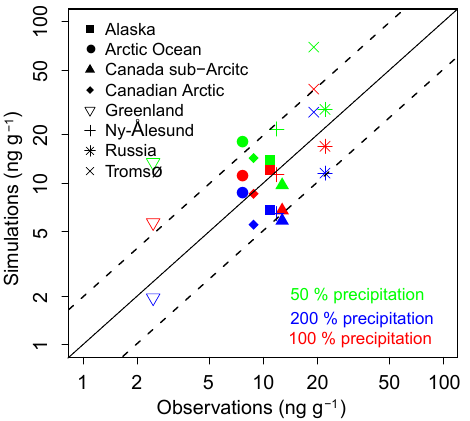
Figure 7. Same as Fig. 3, but for Exp. D with standard precipita- tion (red symbols), 50% precipitation (green symbols), and 200% precipitation (blue symbols). See text for